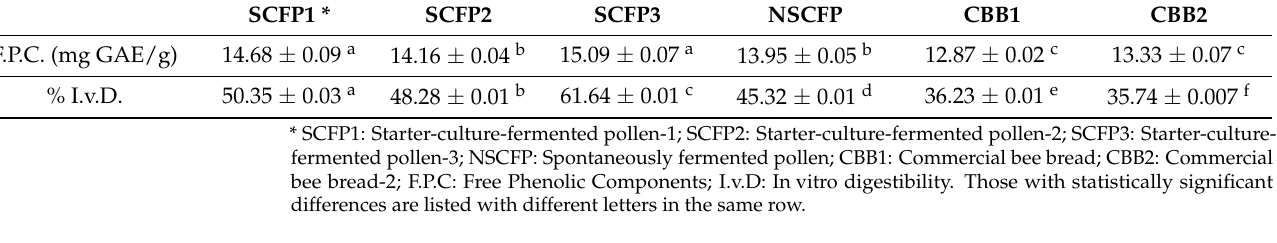
Table 3. Free phenolic components and in vitro digestibility of bee bread. SCFP1 * SCFP2 SCFP3 F.P.C. (mg